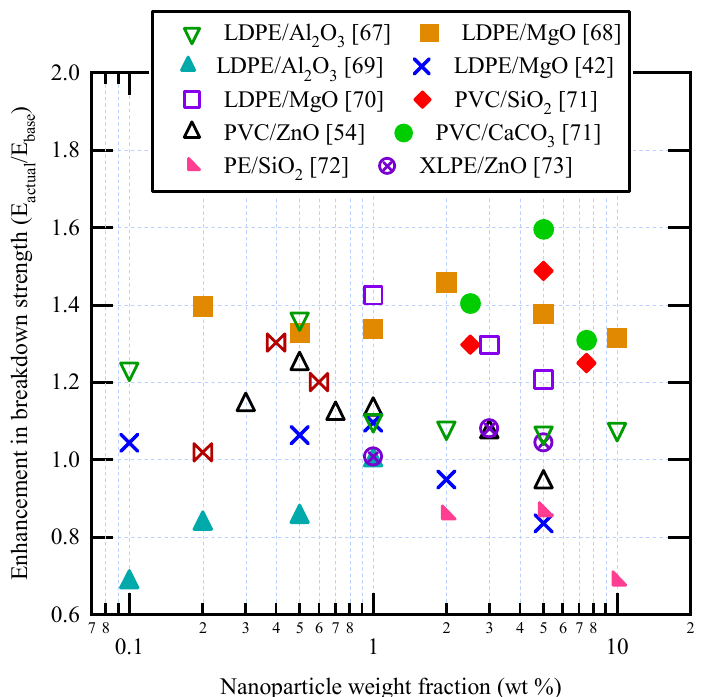
Figure 5. Some published data for DC breakdown strength in polymer nanocomposites. Table 2. DC breakdown strength of polymer nanocomposites based on PE and PVC. Ref.